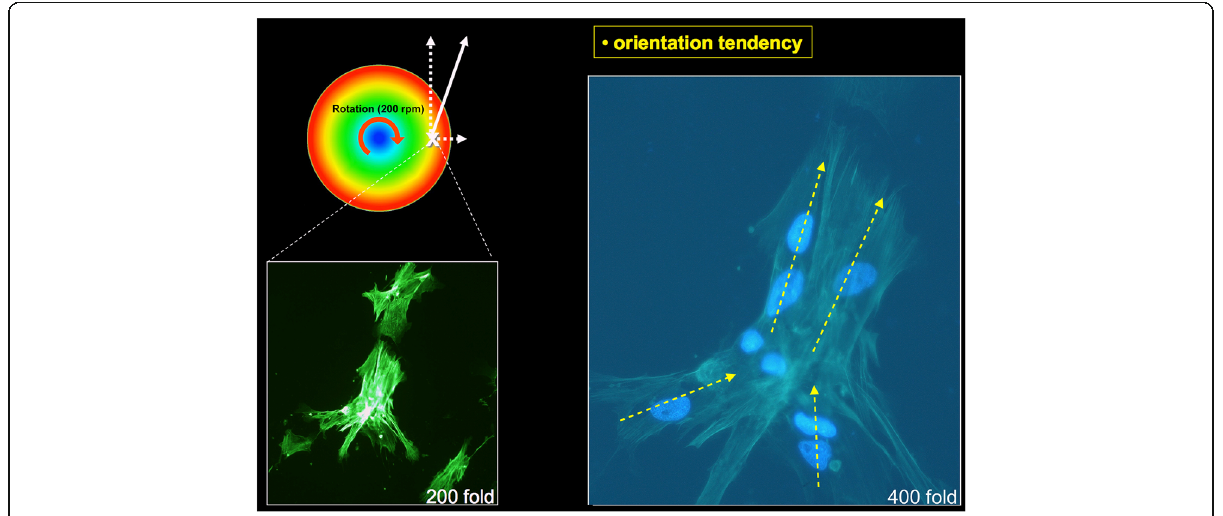
Fig. 5 Osteoblasts with an orientation tendency after 24 h of rotation (phallacidin fluorescence staining). On the left side with 200× and on the right side with 400× magnification. The yellow arrows show the orientation of the cells. The red arched arrow within the coloured circle shows the direction of rotation. The dashed white line oriented to the right stands for the resulting centrifugal force. The dashed white line pointing upwards shows the direction of the resulting flow resistance. The solid white arrow stands for the vectorial sum of the abovementioned